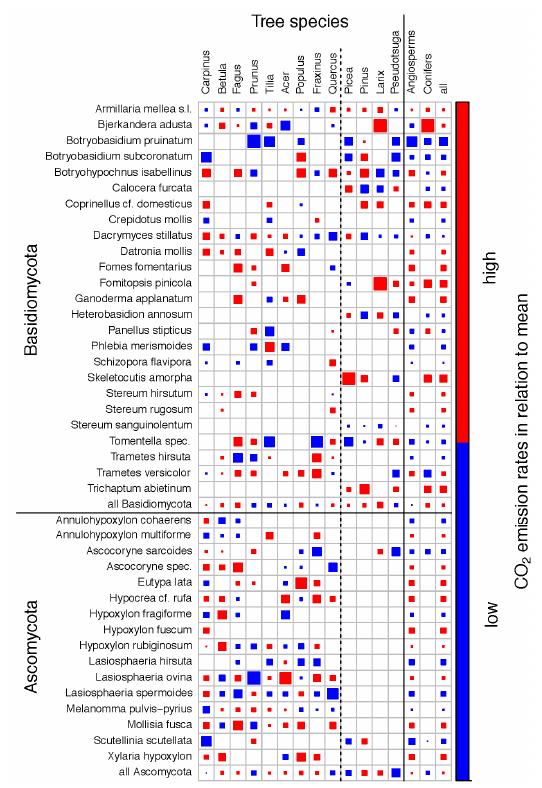
Figure 6. Associations between CO 2 emission rates and occurrence of fungal species (Table S3) for each dead wood tree species. Fungal species are sorted by phylum. Dead wood tree species are sorted as in Figure 2. We used the mean of the linear model residuals for each tree species to classify whether the mean CO 2 emission rate for each fungal species is high (red) or low (blue). The size of the squares gives the strength of the association. For example: a large red square means that there is a strong association with high CO 2 emission